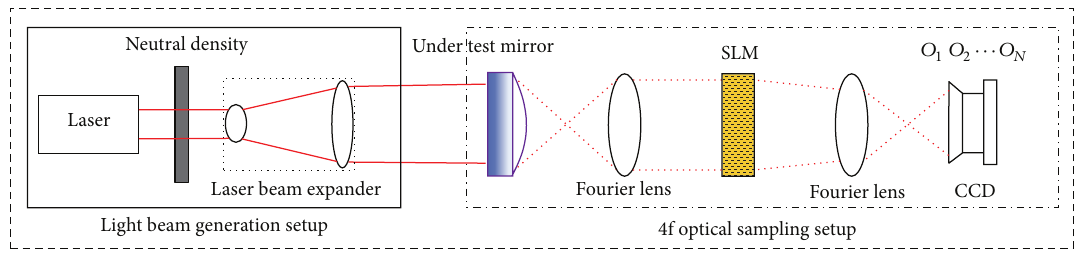
Figure 2: Framework of data sampling module used for optical surface